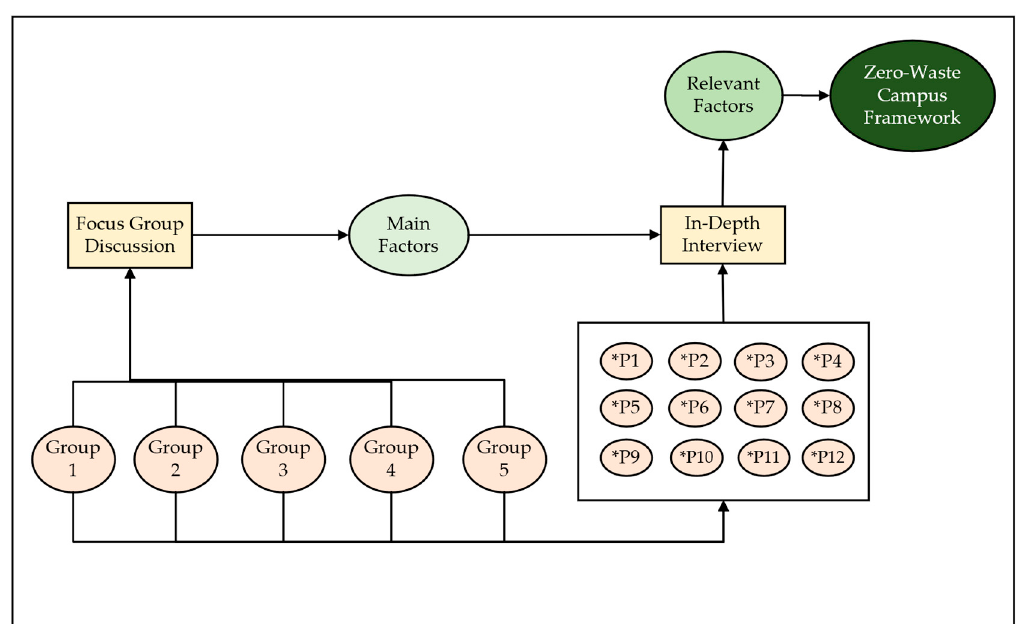
Figure 6. Study methodology. * P: Participant.